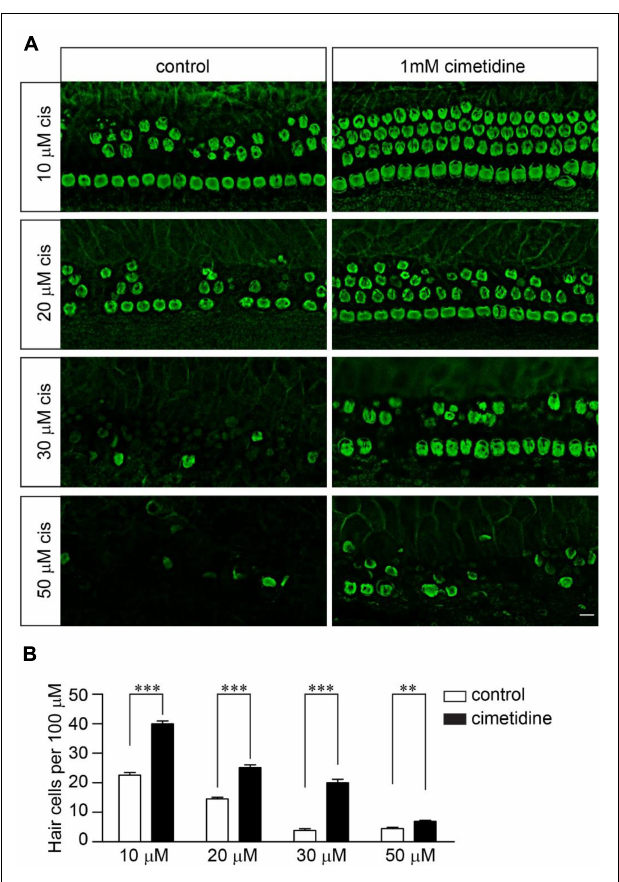
FIGURE 4 | Cimetidine protects wild-type hair cells from cisplatin ototoxicity. (A) Cochlear explants were dissected from P3 wild-type mice and then exposed to different concentrations of cisplatin with/without 1 mM cimetidine for 2 days. The samples were then fixed and labeled with an antibody against β 2-spectrin. Note, 1 mM cimetidine partially protected hair cells from cisplatin ototoxicity. Scale bar: 10 µ m. (B) Numbers of hair cells per 100 µ m in the middle region of the cochlea (5 mice per group, 10 µ M cisplatin; 6 mice per group, 20 µ M cisplatin; 3 mice per group, 30 µ M cisplatin; 3 mice per group, 50 µ M cisplatin). Data are represented as the mean ± SE. ∗∗ p < 0.01 and ∗∗∗ p < 0.001 by Student’s t -test.